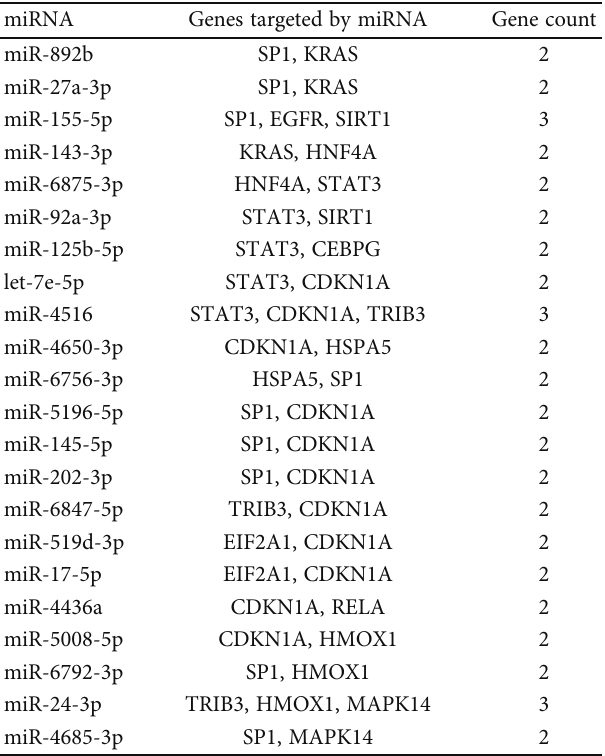
Table 3: The miRNAs with higher amounts of cross-linked DEGs ( n ≥ 2